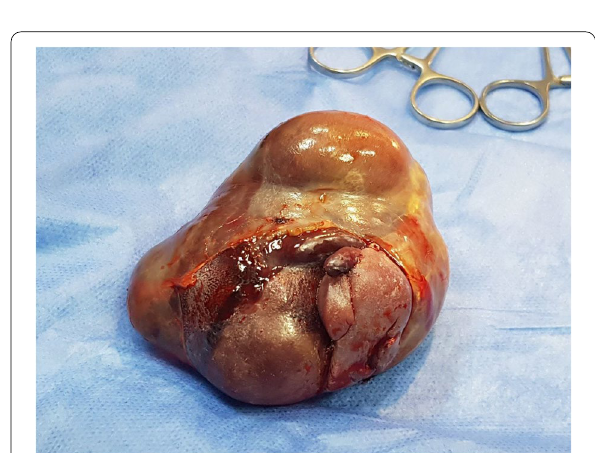
Fig. 6 Extracted fetal mass